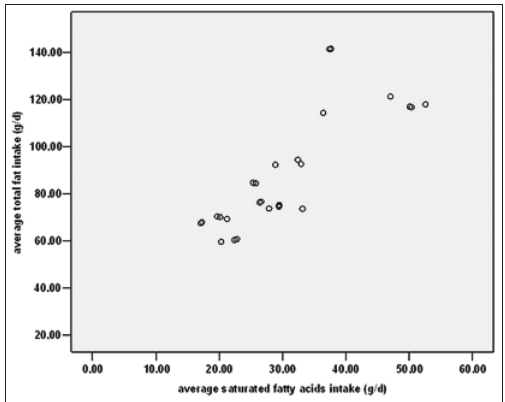
FIGURE 5. Link between SFAs and total fat intake in male students